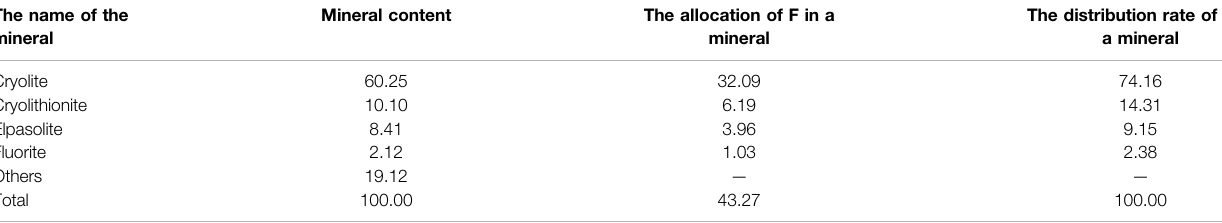
Mineral content The allocation of F in a